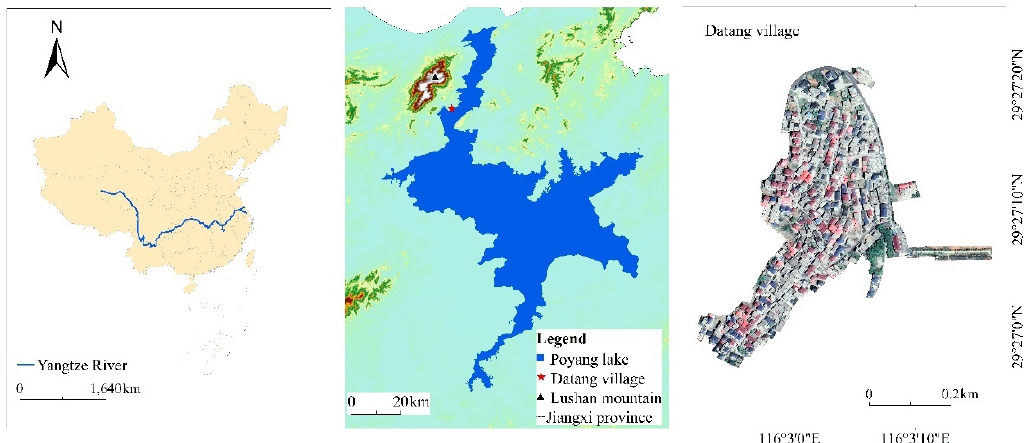
Figure 2. Location Map of Datang Village (Source: collated by the author).